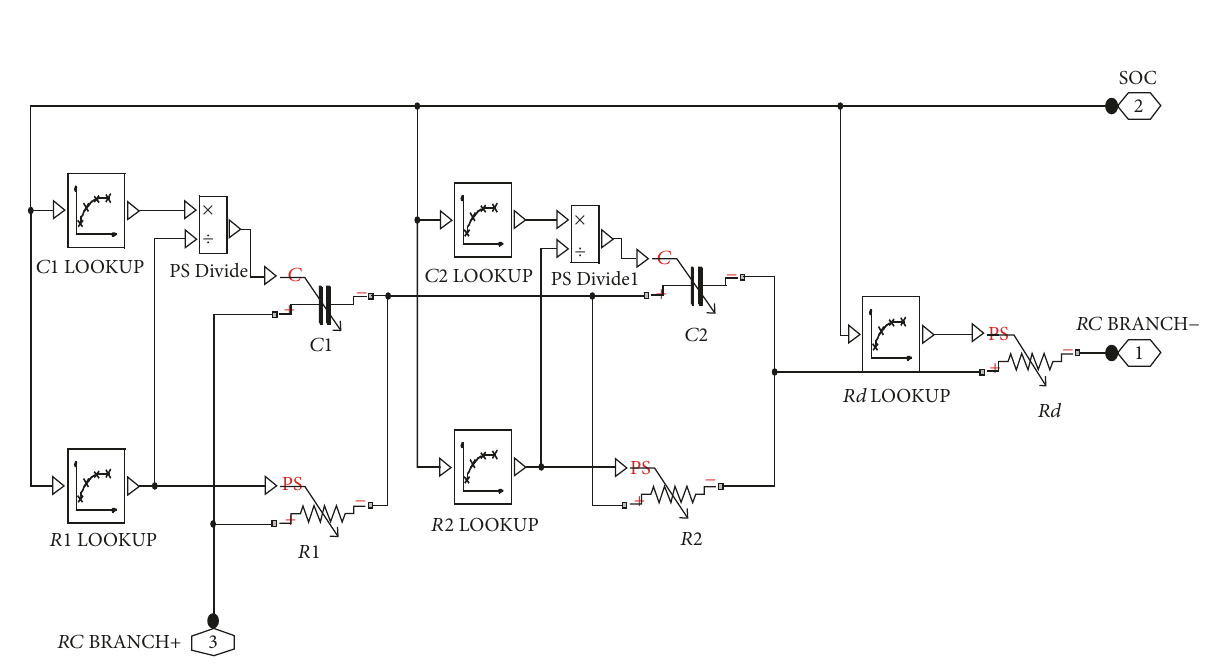
Figure 6: 2- 𝑅𝐶 equivalent circuit model of battery